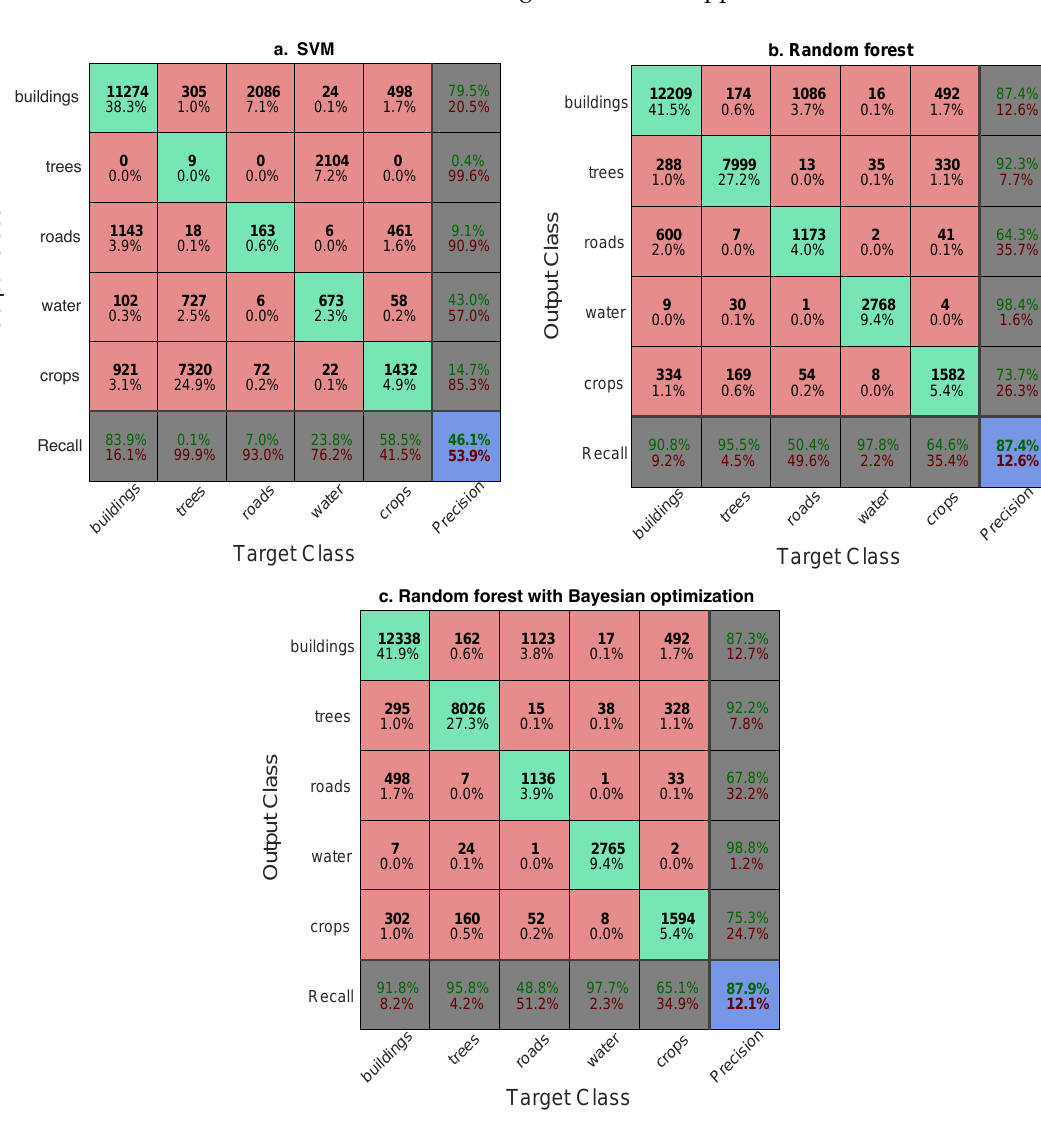
Figure 6. Confusion matrices of three machine learning based classifiers ( a ) SVM, ( b ) Random forest, ( c ) Random forest with Bayesian optimization) by using RGB band